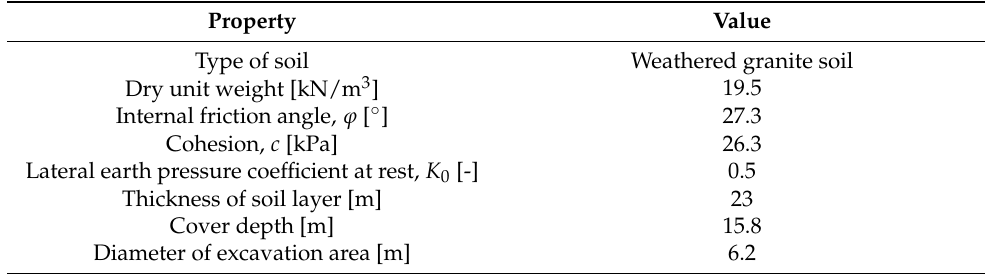
Table 1. Ground conditions of numerical model for earth pressure balance (EPB) shield tunnelling